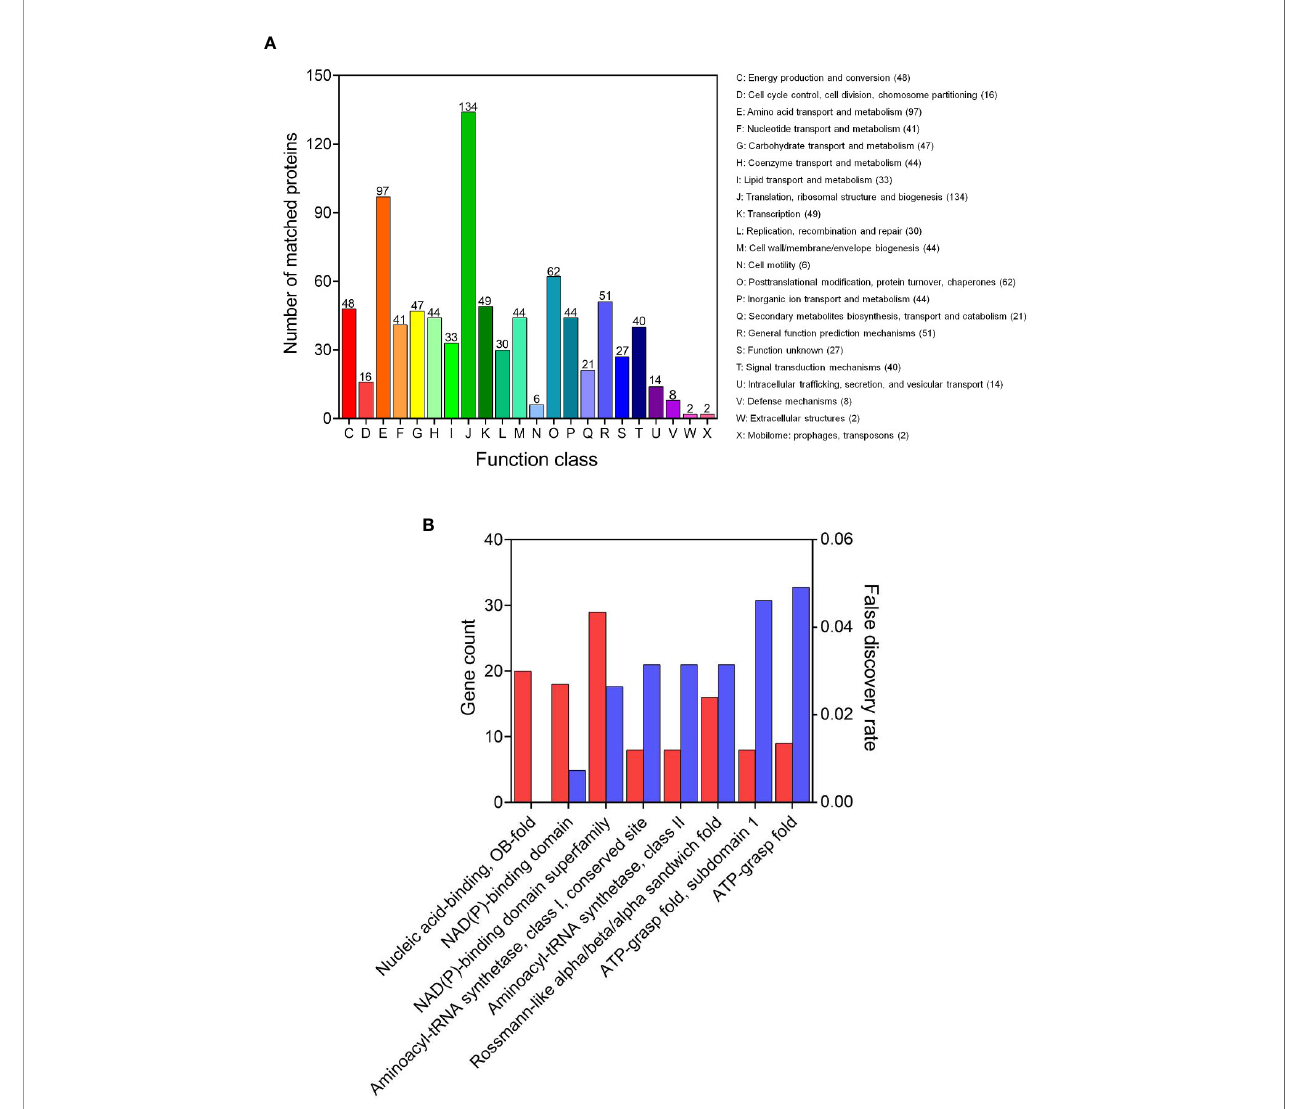
FIGURE 3 | Functional annotation of the lysine succinylome in V. alginolyticus . (A) The COG analysis and (B) domains enrichment analysis of the succinylated